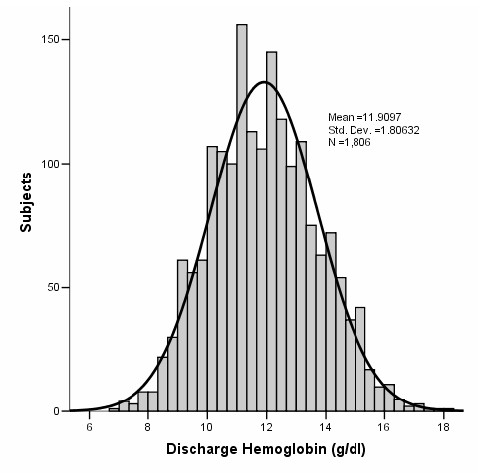
Discharge hemoglobin values among hospital survivors. For this graph, we analyzed the last hemoglobin measurement in subjects discharged alive from the hospital (n = 1806). Hemoglobin was measured on the day of discharge in 512 (28.3%) subjects and within 48 hours before discharge in an additional 795 (44%) subjects. For a minority of subjects (n = 164, 9%), the last available hemoglobin concentration measurement was more than 96 hours before discharge. Mean (SD) discharge hemoglobin was 11.9 (1.8) g/dL, indicating that the average hospital survivor had mild anemia at discharge.